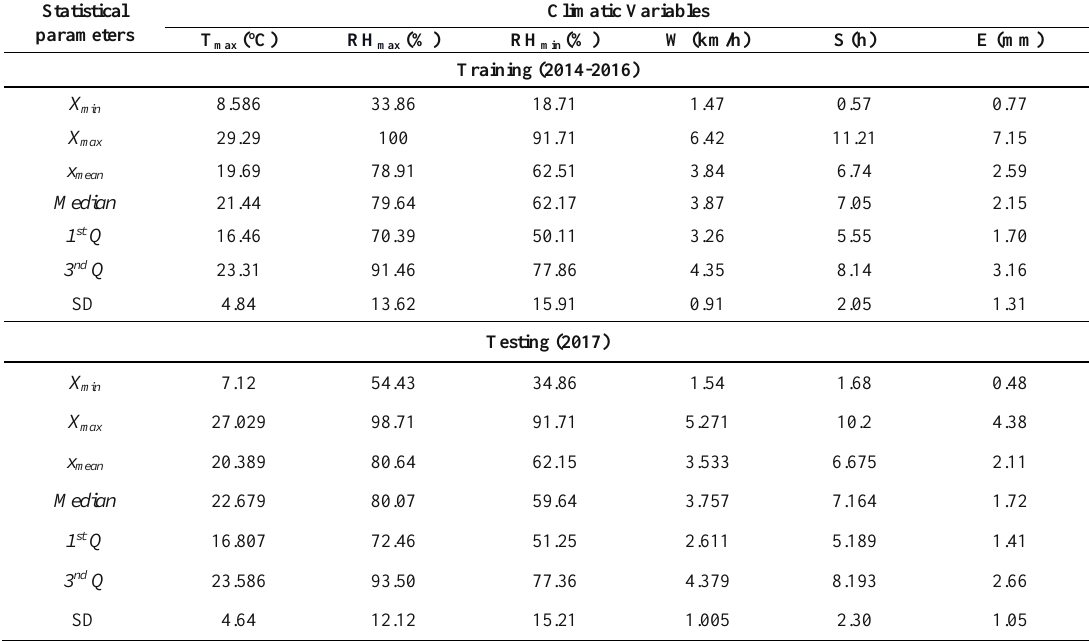
Table 1 . Statistical parameters of training, testing, and complete weekly climatic dataset of maximum temperature (T max ), maximum relative humidity (RH max ), maximum relative humidity (RH min ), Wind Speed (W), sunshine hours (S), and pan evaporation (E) of the study area. x min , x max , x mean , SD, 1 st Q, 3 rd Q, are minimum, maximum, mean, standard deviation first quartile, and third